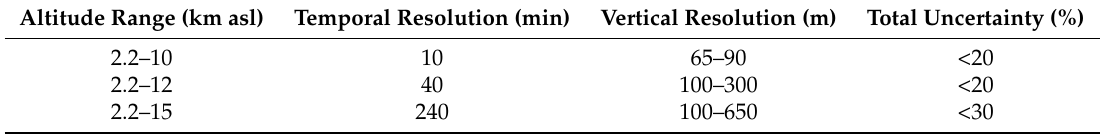
Table A1. User’s guide for the Lidar1200 water vapor data treatment regarding the altitude range and current associated uncertainties. It corresponds to total uncertainties on the mean signals for 10-, 40- and 240-min integration (Figure